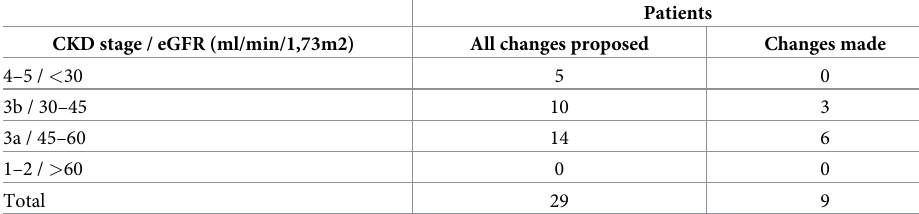
Table 8. Number of patients for whom a change is proposed and those for whom a change is made.